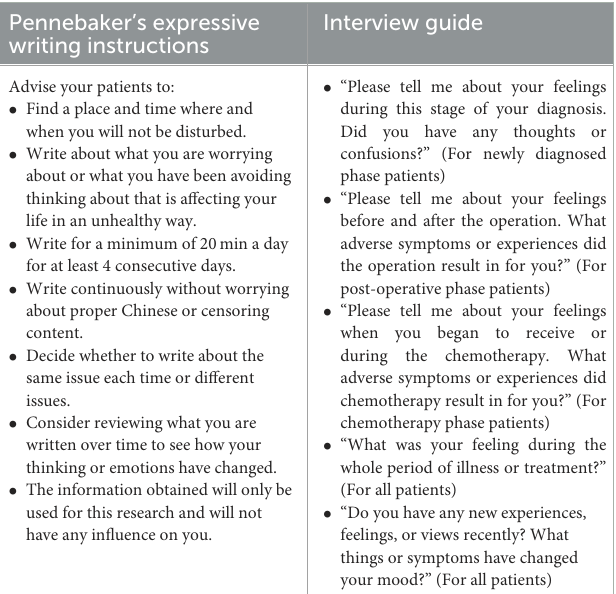
TABLE 3 Pennebaker’s expressive writing instructions and interview